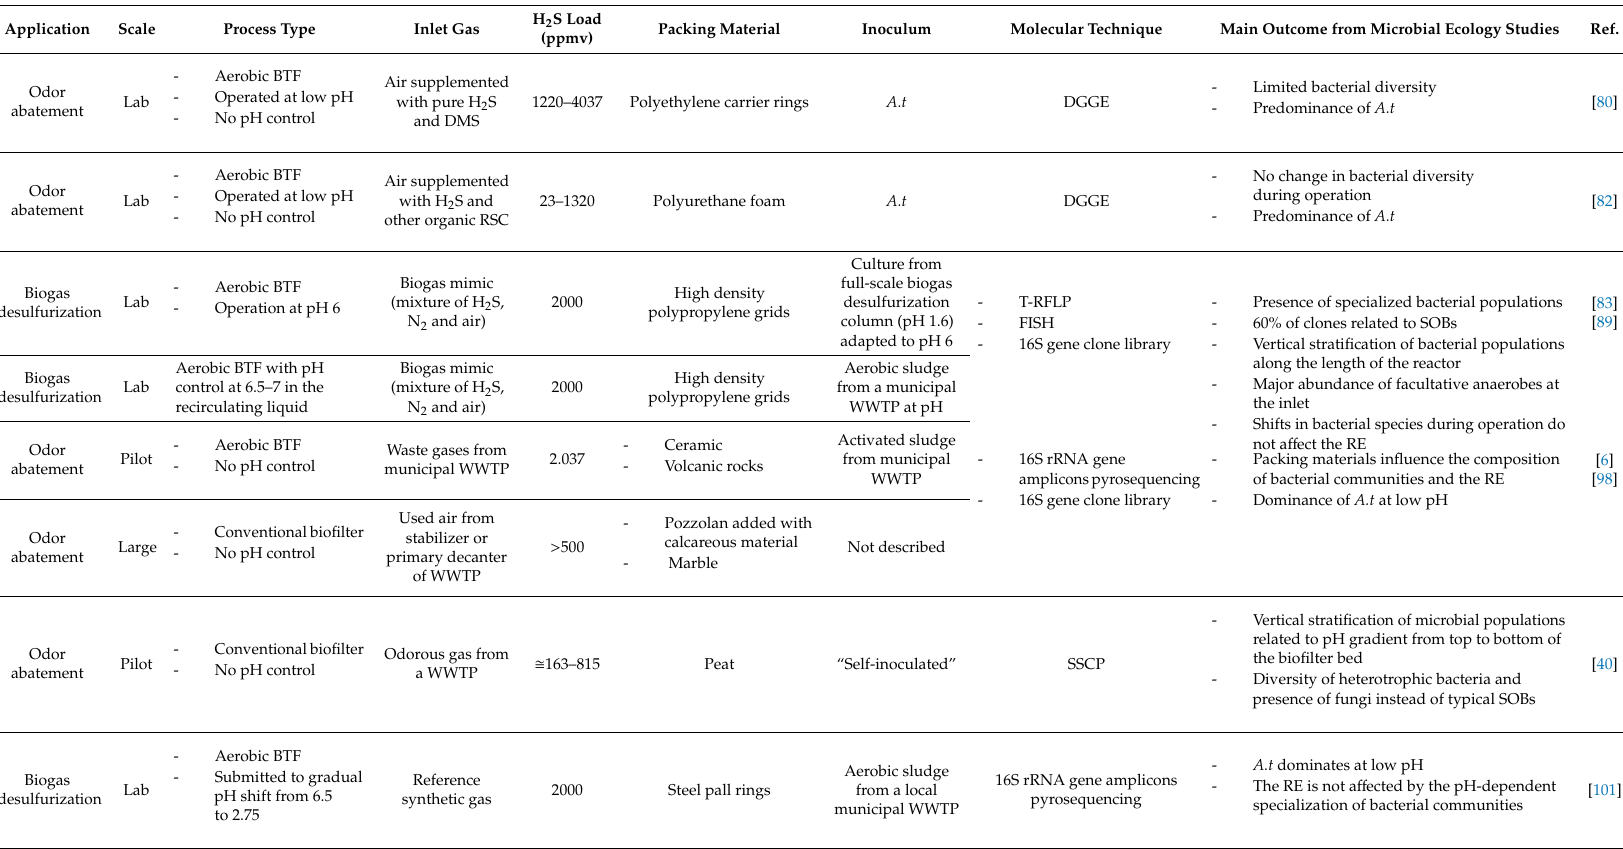
Table 5. Main outcomes of molecular microbial ecology studies on conventional biofilters and BTFs used for the removal of H 2 S in odor abatement and biogas desulfurization applications. A.t : Acidithiobacillus thiooxidans ; DGGE: denaturing gradient gel electrophoresis; DMS: dimethyl sulfide; FISH: fluorescence in situ hybridization; RSC: reduced sulfur compound; SSCP: single-strand conformation polymorphism; T-RFLP: terminal restriction fragment length polymorphism; UASB: upflow anaerobic sludge blanket; WWTP: wastewater treatment